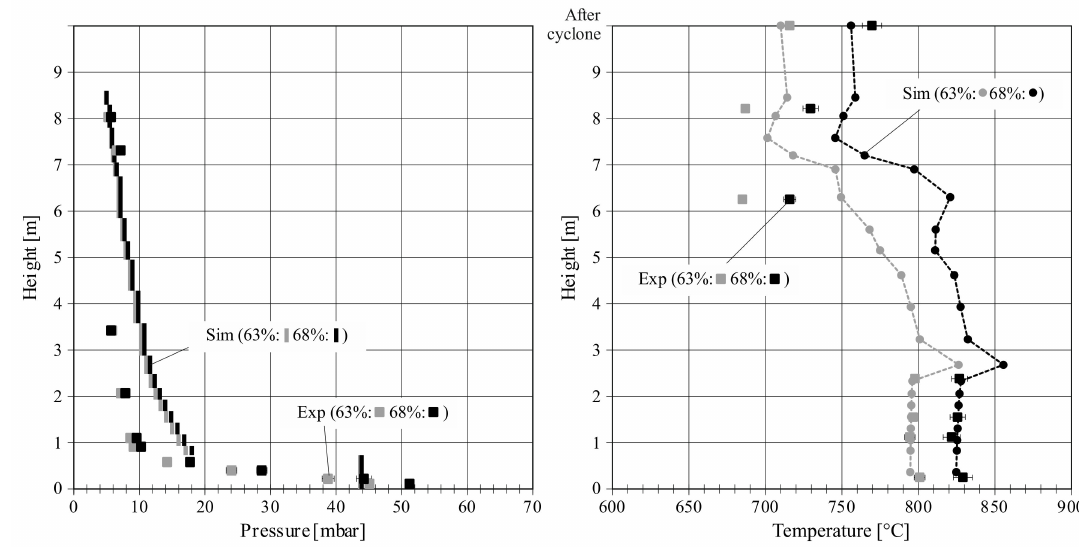
Figure 9. Pressure and temperature along the reactor at low